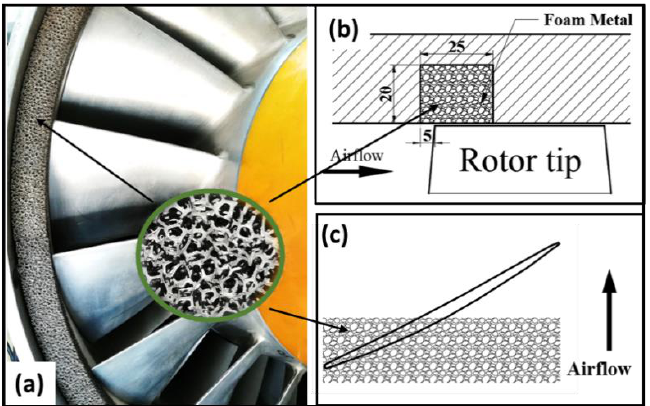
Figure 3. Configuration of the FMCT. ( a ) photograph of the FMCT, ( b ) side schematic view, ( c ) top schematic view.